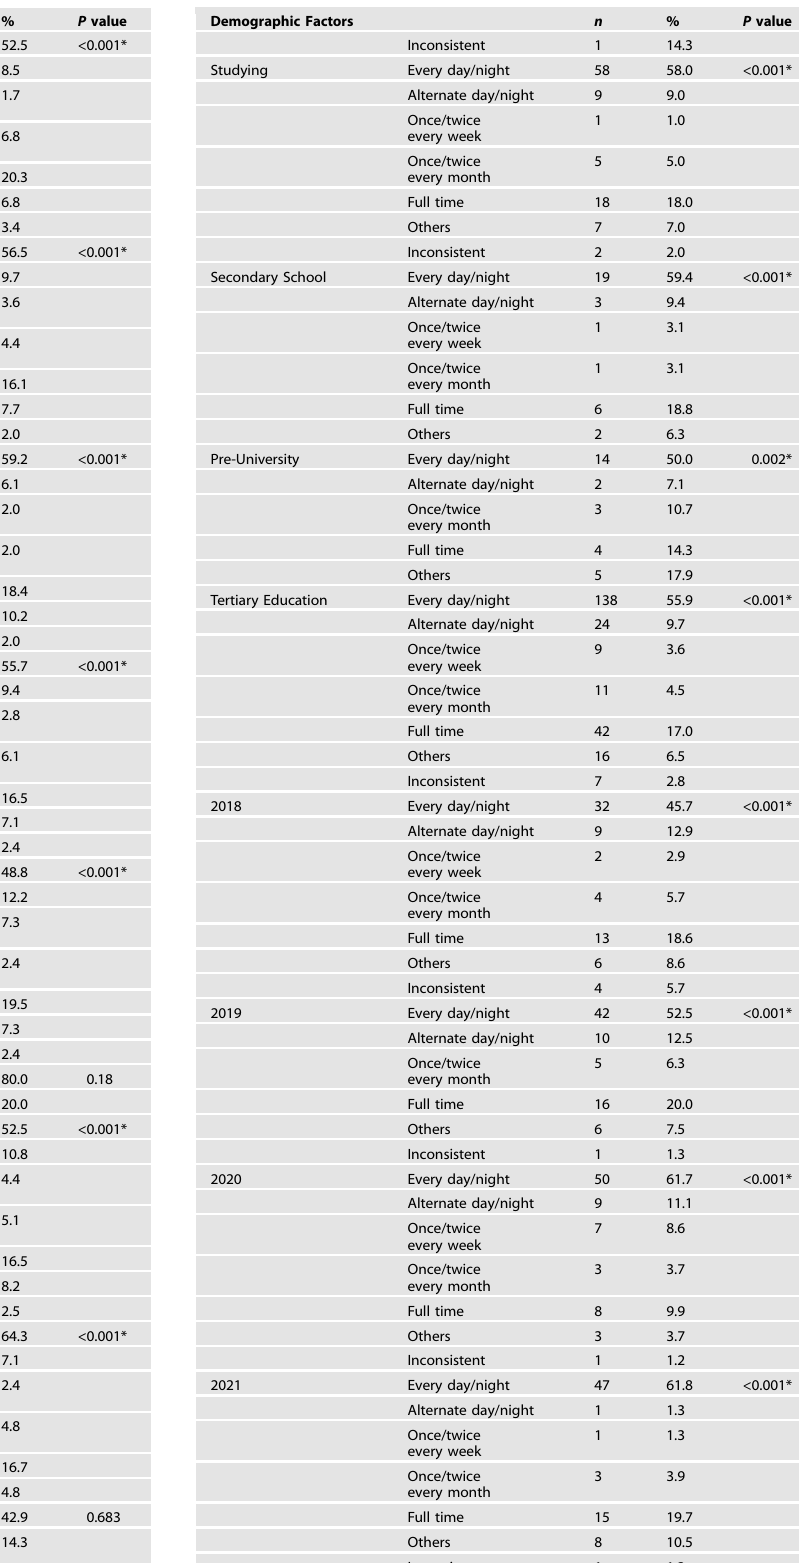
Table 5. Actual wear time according to demographic factors. Table 5.